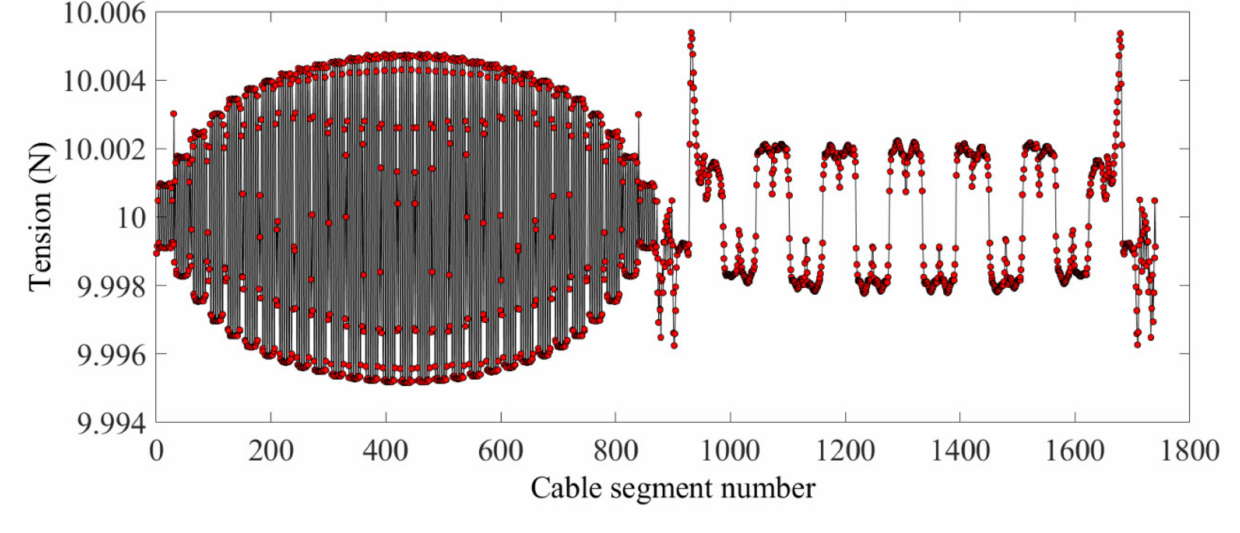
Figure 13. The internal cable segment tension.